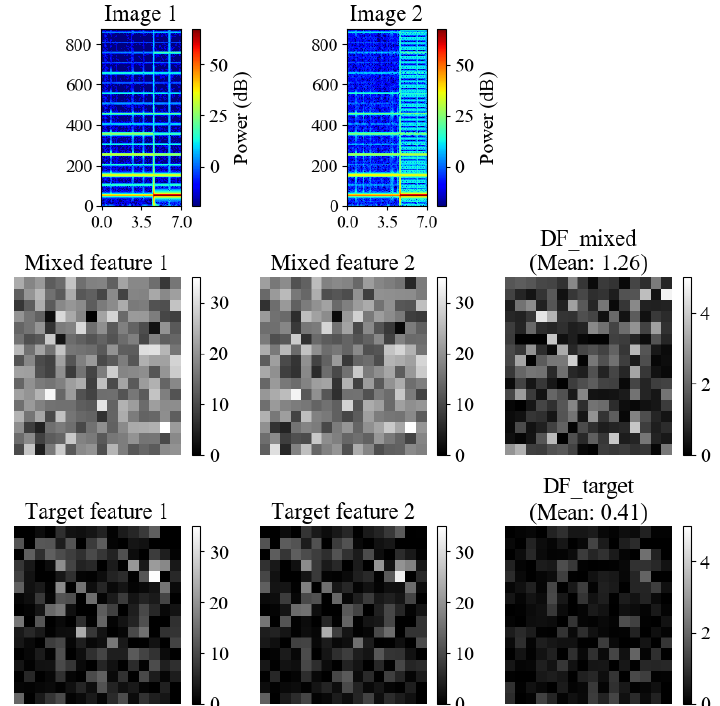
Figure 7. An example of the network Concatenate-DenseNet-121’s response at different layers. The model input is two kettle samples with different background loads. For each layer, the output is reshaped to form a 2D